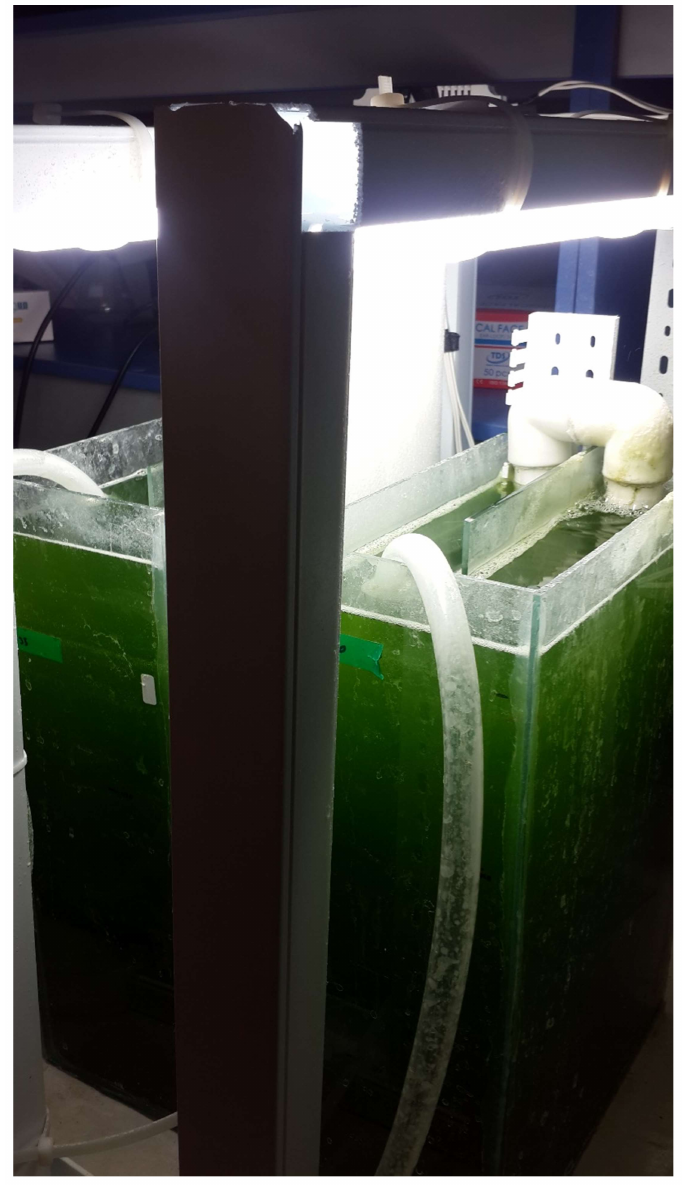
Figure 5. Raceway pond and airlift pump (RWPAP)